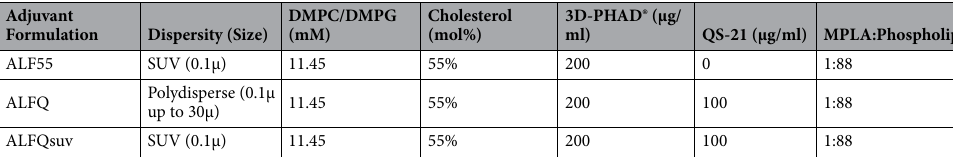
Table 1. Composition of ALF55, ALFQ and